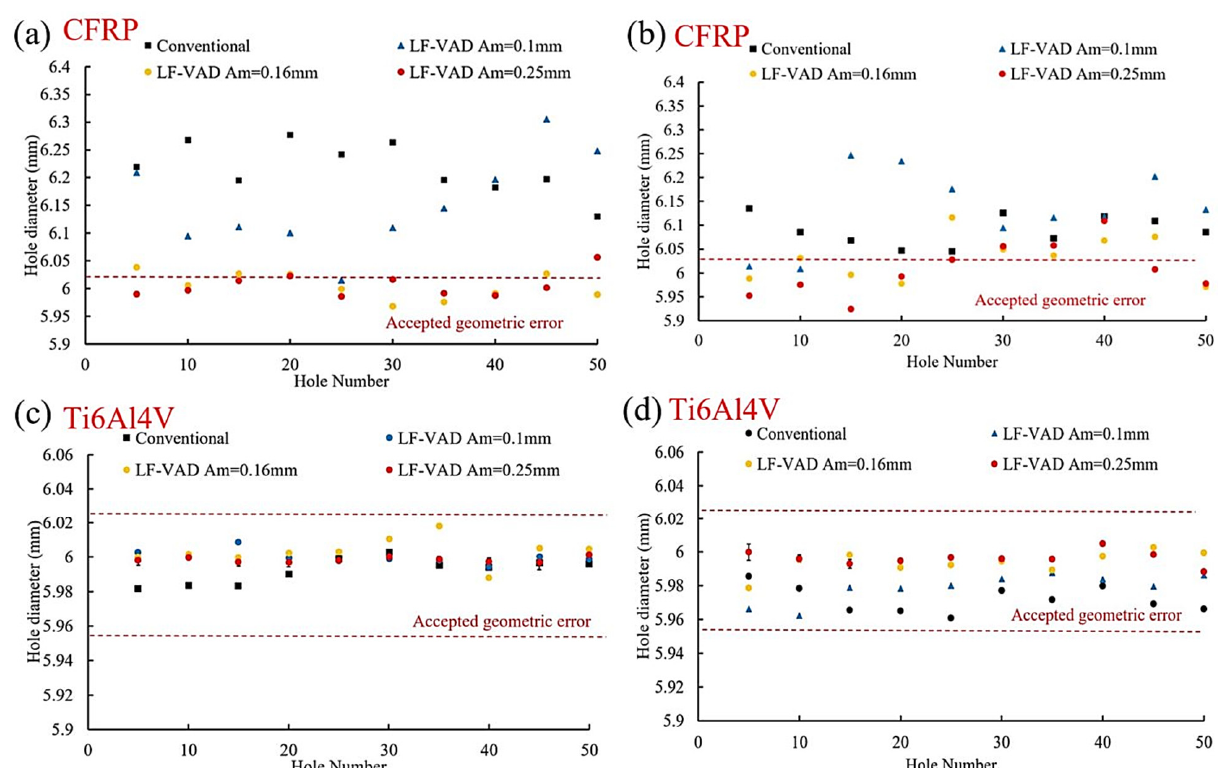
Figure 15. Effect of vibration amplitude on the CFRP and Ti6Al4V hole accuracy at different cutting speeds ( a , c ) N = 2000 rpm, ( b , d ) N = 3000 rpm.